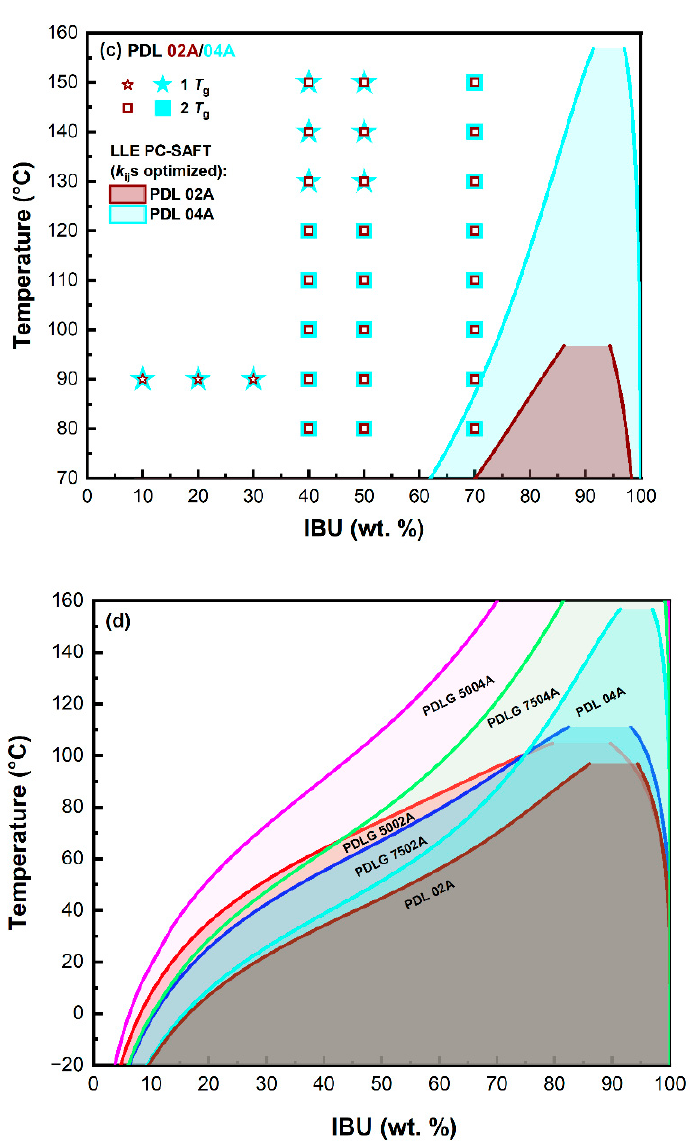
Figure 3. Comparison of LLE areas determined using DSC measurements with those predicted using the PC-SAFT EOS: ( a ) PDLG 5002A/5004A, ( b ) PDLG 7502A/7504A, and ( c ) PDL 02A/04A. ( d ) Comparison of LEE regions modeled by PC-SAFT.